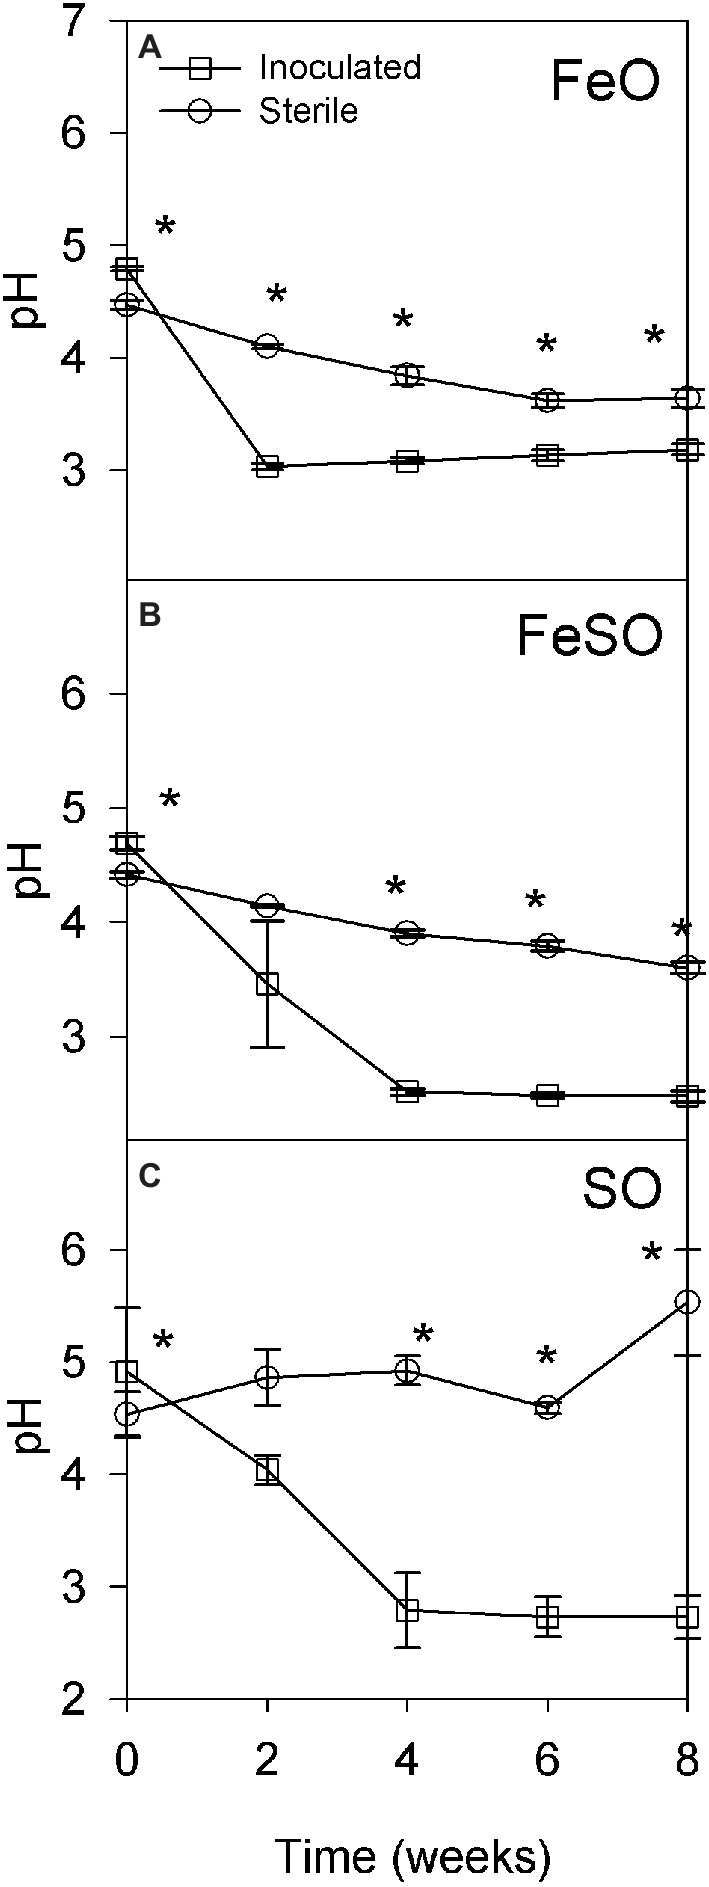
Microcosm experiment to determine pH as a function of time under sterile and inoculated conditions in an unbuffered initially moderately acidic system containing iron and/or sulfur. Three treatments were examined: (A) iron oxidation conditions (FeO), (B) iron and sulfur oxidation conditions (FeSO), and (C) sulfur oxidation conditions (SO). Asterisks (*) denote significantly different (p < 0.01) pH values between inoculated and sterile cultures at that time point within the experiment. Error bars indicate one standard deviation.